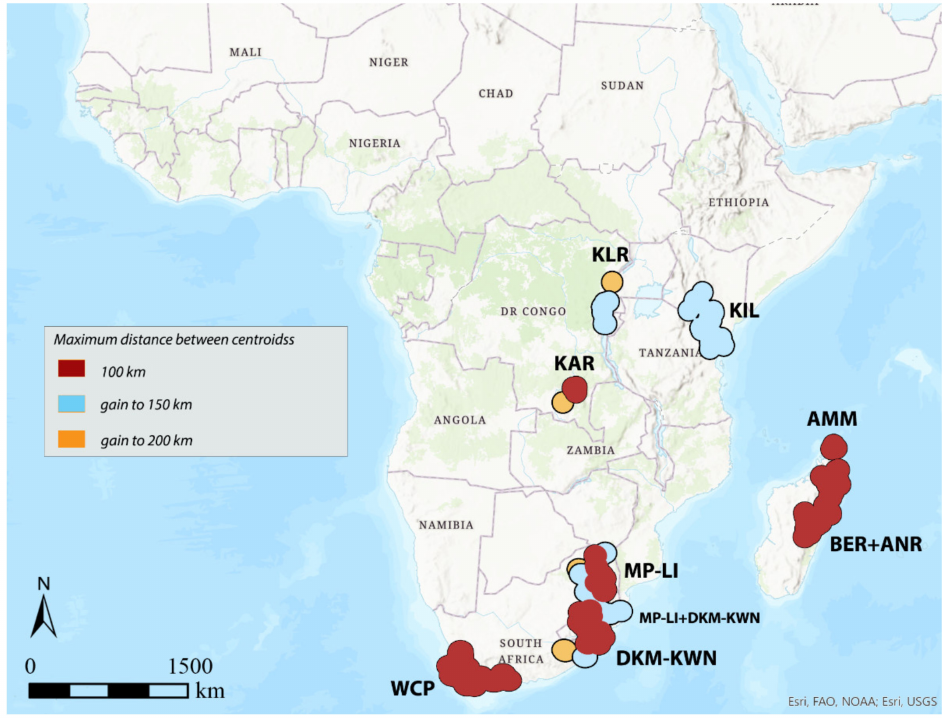
Figure 6. Areas of endemism detected by DBSCAN using species with distribution range up to 500 km and distance between centroids to 100, 150, and 200